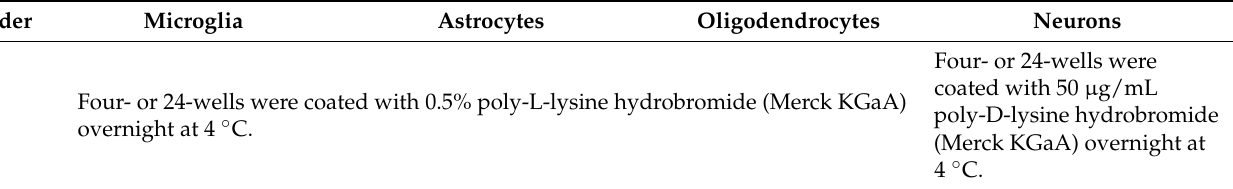
Table 3. Cultivation of isolated CNS-resident